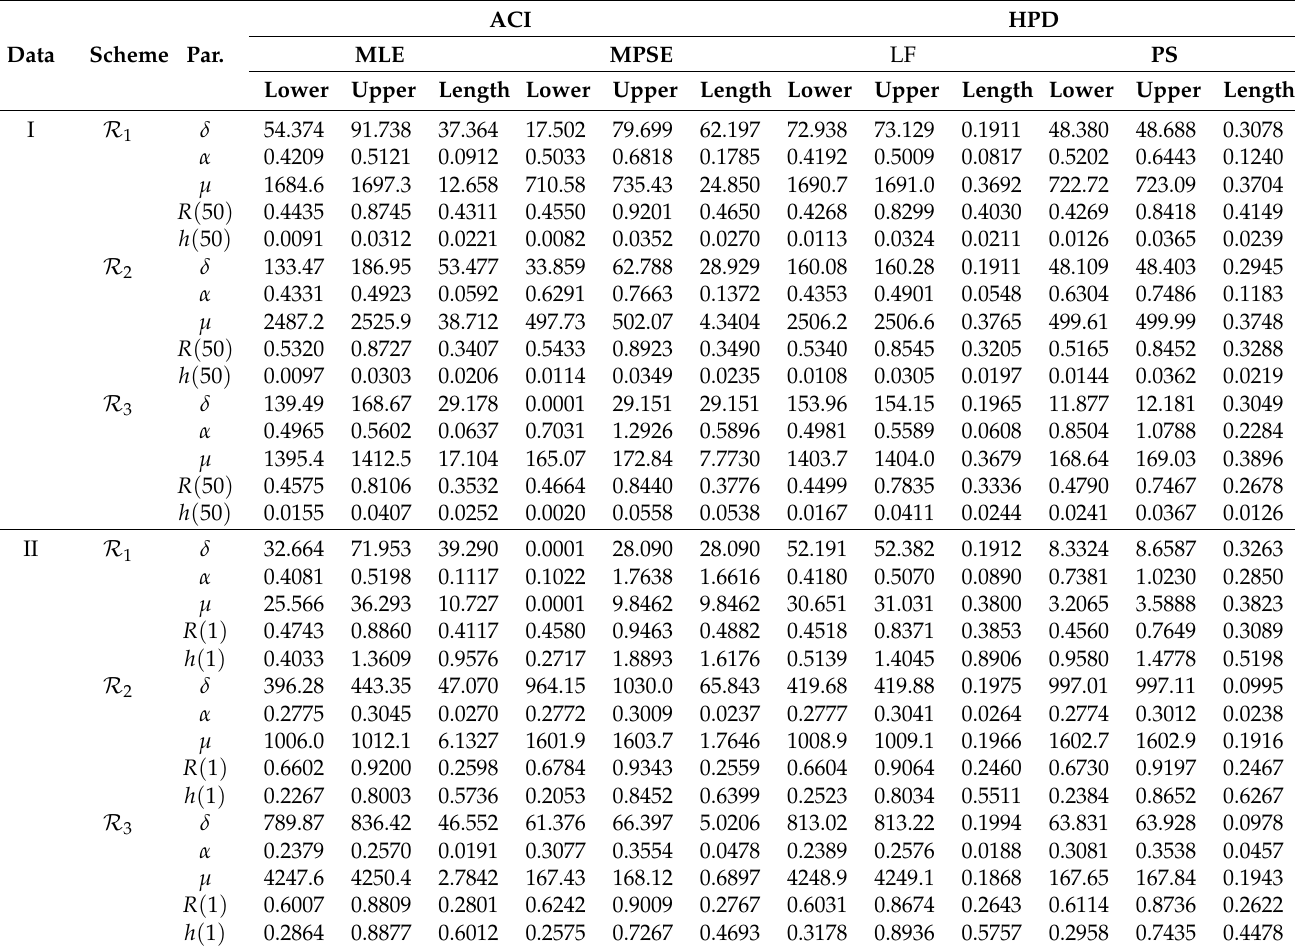
Table 7. Interval estimates of δ , α , µ , R ( t ) and h ( t ) based on data sets I and II.